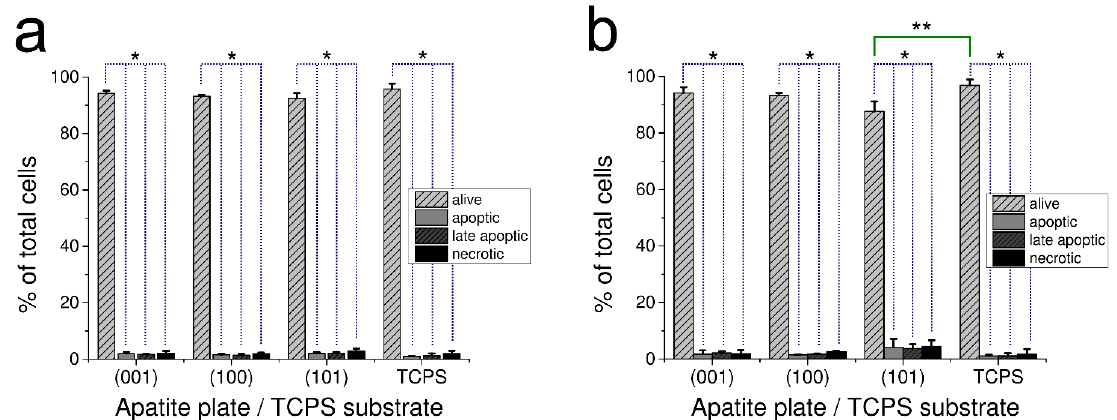
Figure 3. Effect of GAp ( a ) and YAp ( b ) apatite plates after 48 h of incubation on fibroblast apoptosis and necrosis. Control cells were grown on TPCS. The number of alive, apoptotic, late apoptotic or necrotic cells are expressed as the percentage of total cells that were grown on the plate of particular crystallographic orientation. The values are expressed as a mean percentage of three independent experiments with standard deviation. * Significant difference ( p < 0.05) between alive and dead cells (dotted line). ** Significant difference ( p < 0.05) between the alive cells of (101) YAp and TCPS (continuous line).